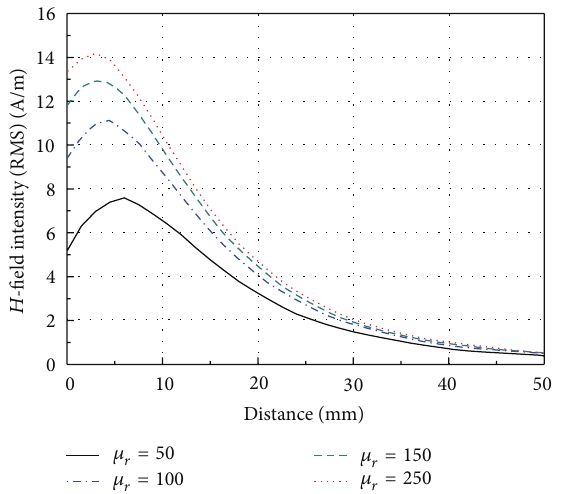
Figure 2: Simulated 𝐻 -field intensity along with a normal direction ( 𝑧 -axis) on the center of the 4-turn loop antenna by varying relative permeability of a ferrite sheet (thickness = 80 𝜇 m).